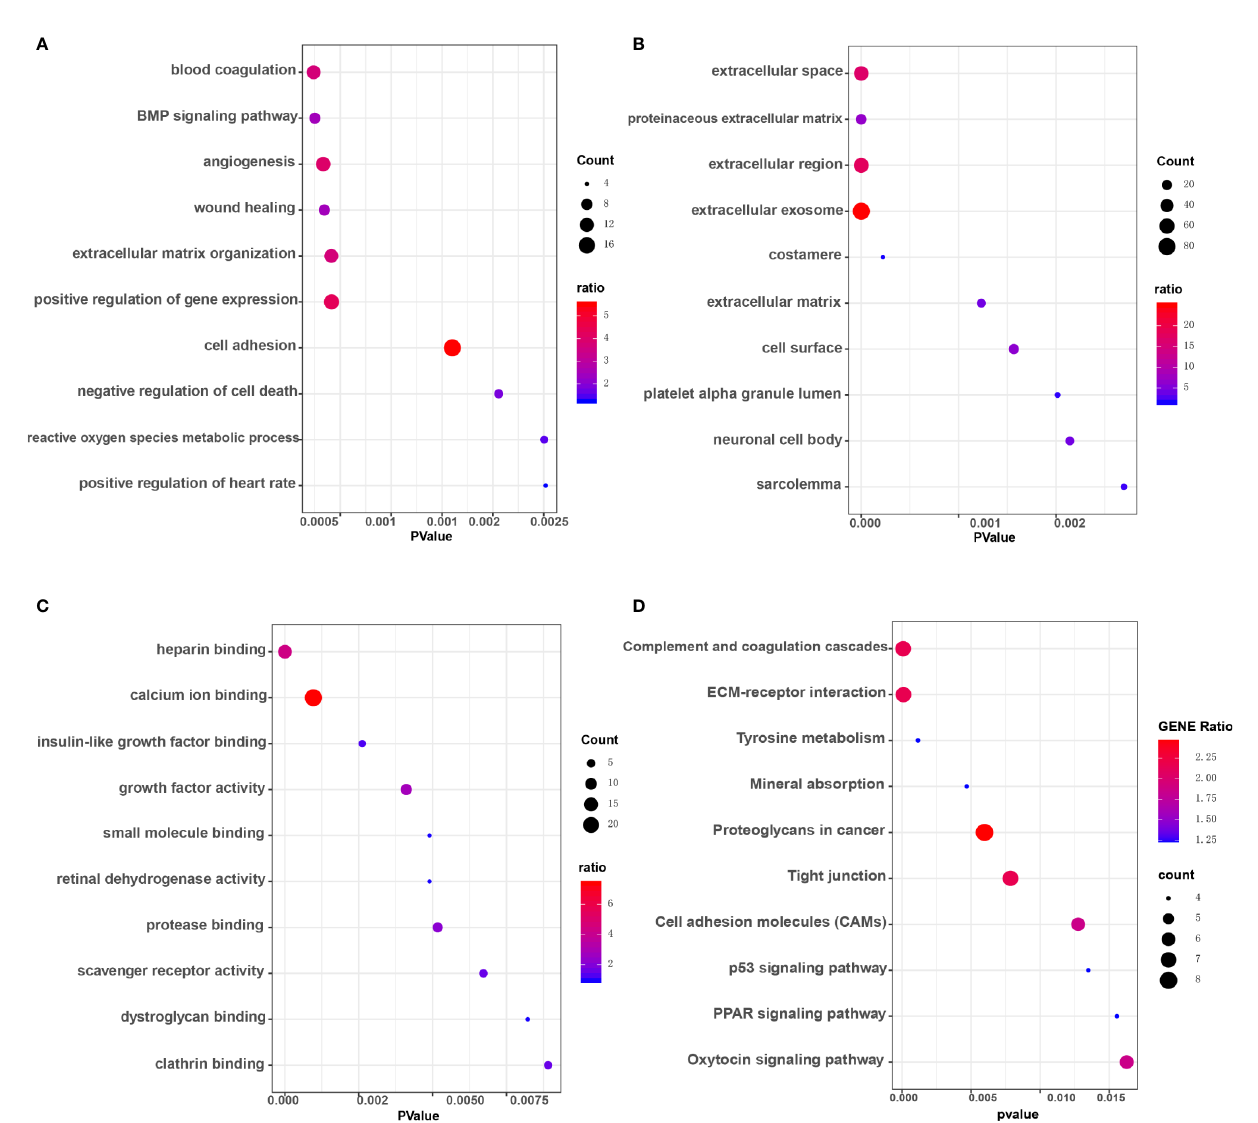
FIGURE 3 | GO enrichment and KEGG pathway analysis of overlapping DEGs in at least three microarray datasets. (A) Biological processes (BP) enrichment analysis. (B) Cellular components (CC) enrichment analysis. (C) Molecular function (MF) enrichment analysis. (D) KEGG pathway